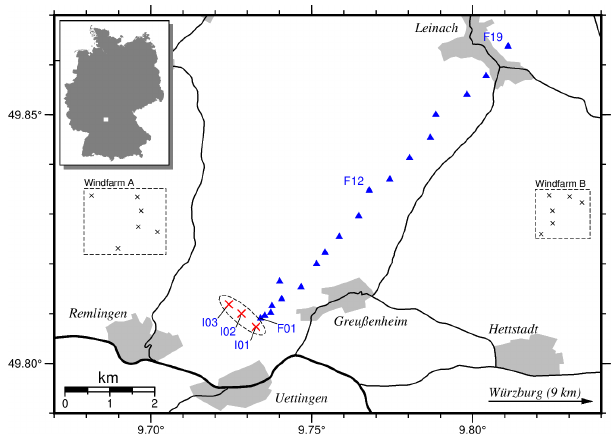
Figure 1. Location of the wind farm in Uettingen (red crosses) and seismic profile stations F01 to F19 (blue triangles). Three additional seismic stations are positioned in the WT cellars (I01, I02, I03). Wind farms A and B (dashed boxes) are not targeted by our experi- ment but are located in the